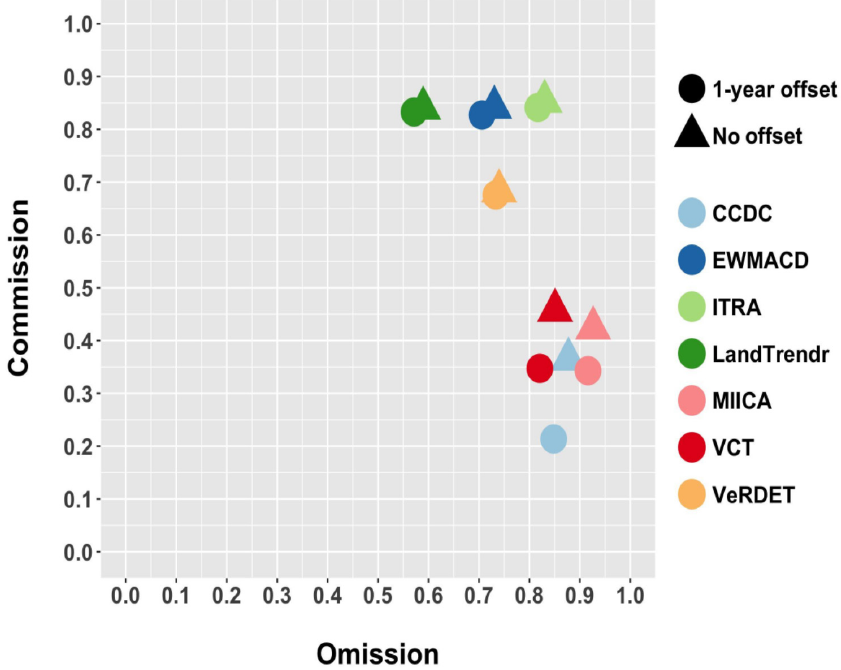
Figure 6. Omission and commission rates for each of the seven map product sets. One ‐ year offset allows for agreement between map disturbance and reference data to be off by one year.